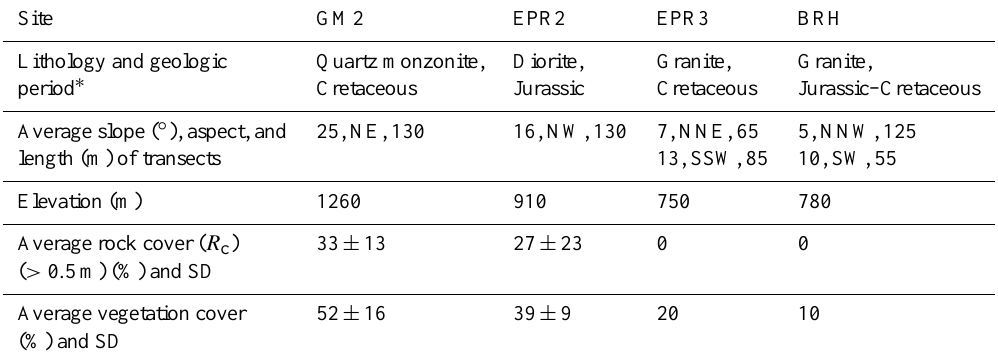
Table 1. The study sites characteristics.